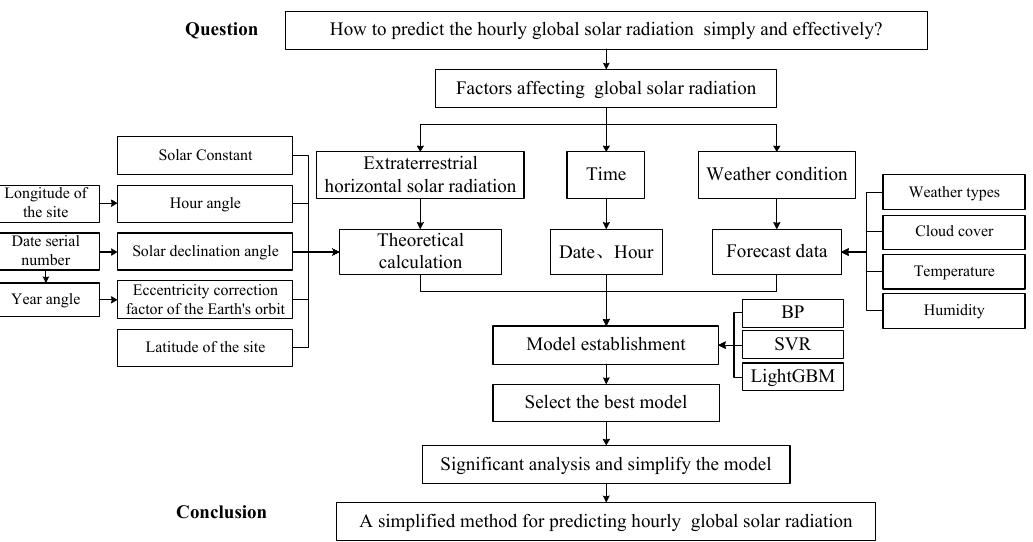
Figure 1. Flowchart of the establishment of the hourly global solar radiation prediction model.